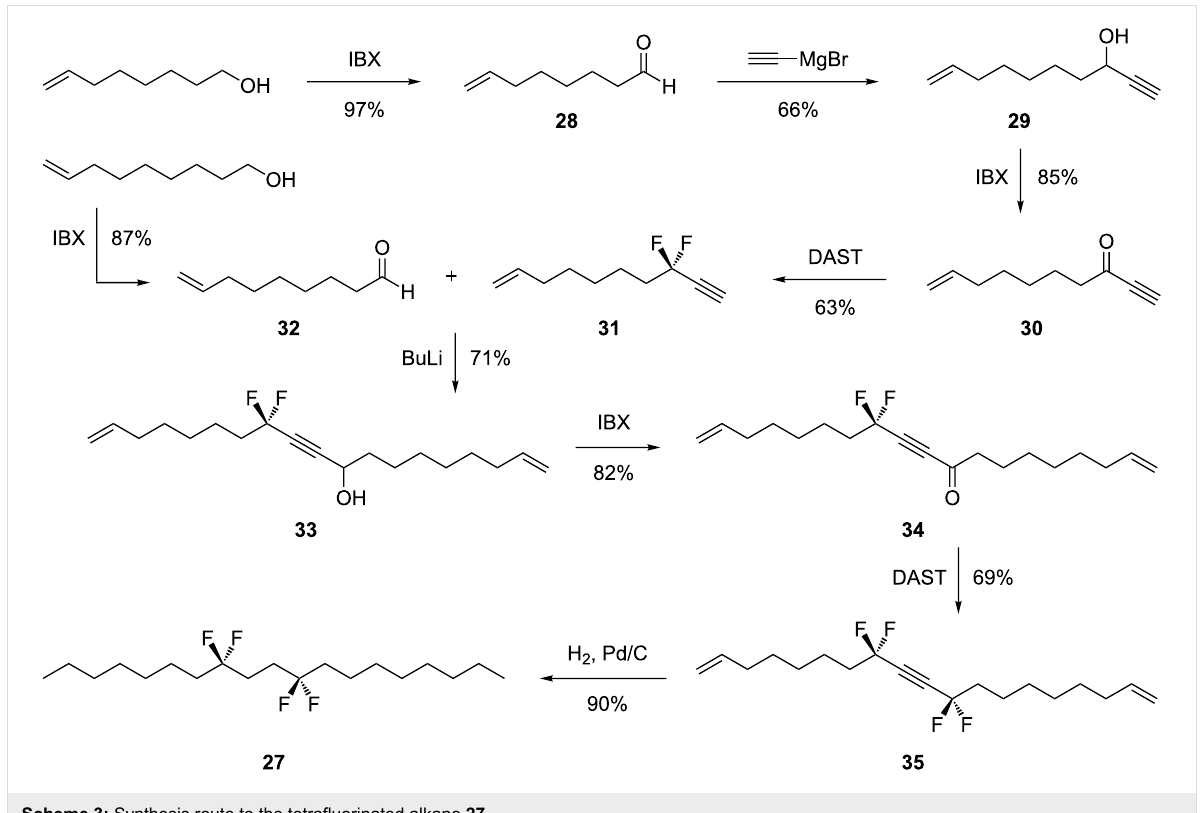
be a crystalline solid (mp 35–37 °C) with a melting point very similar to nonadecane (32–35 °C). A suitable crystal was subject to X-ray structure analysis and the resultant structure is shown in Figure 7. It is clear that the alkyl chain of 27 is extended in a similar conformation to that found in palmitic acid 6c and we conclude that this is the preferred conformation of this motif in a hydrocarbon